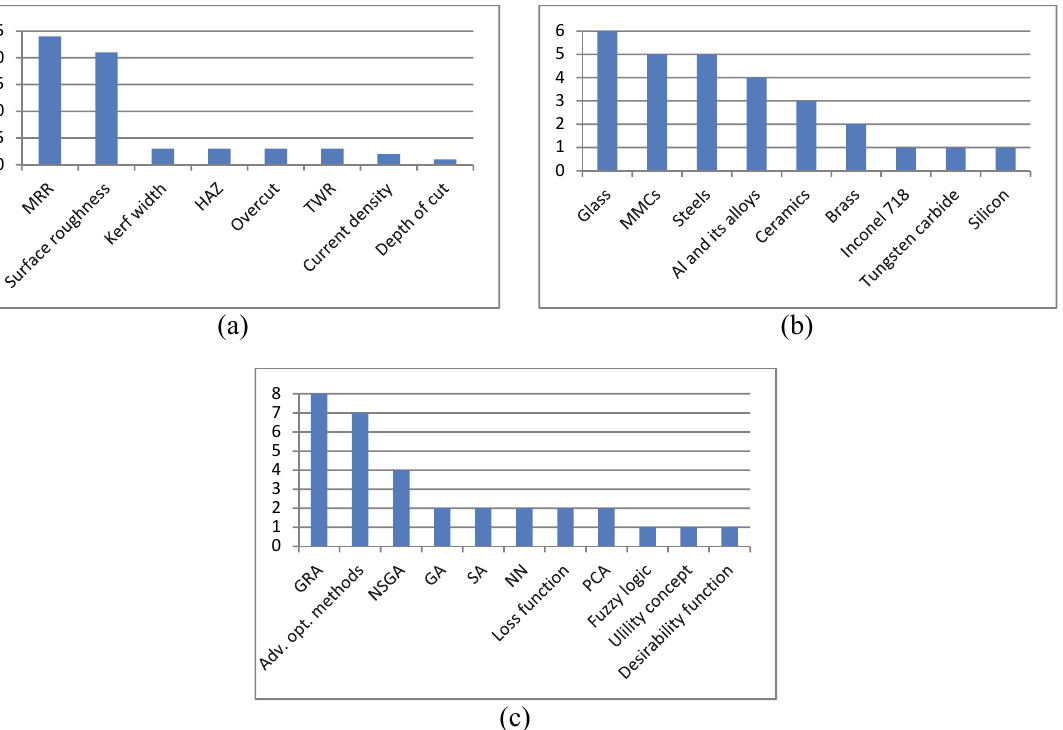
Fig. 6 Analysis on the parametric optimization of HM